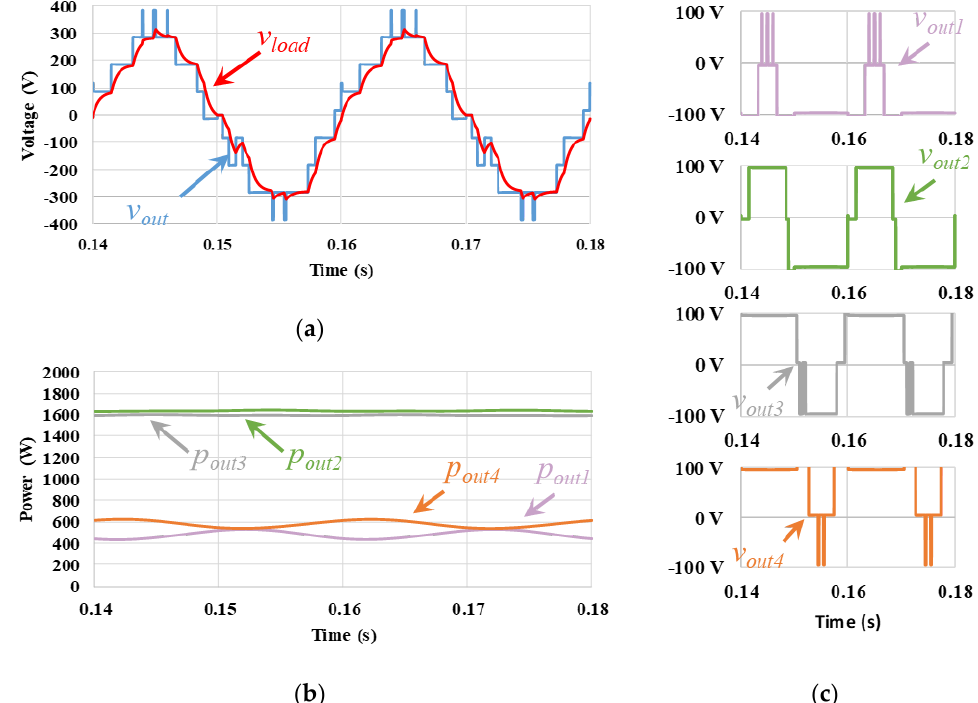
Figure 20. Simulation results of the VF PWM technique: ( a ) output voltage of the cascaded MLC, v out , and load voltage, v load ; ( b ) output power on each submodule ( p out1 , p out2 , p out3 , p out4 ); ( c ) output voltage on each submodule ( v out1 , v out2 , v out3 , v out4 ).